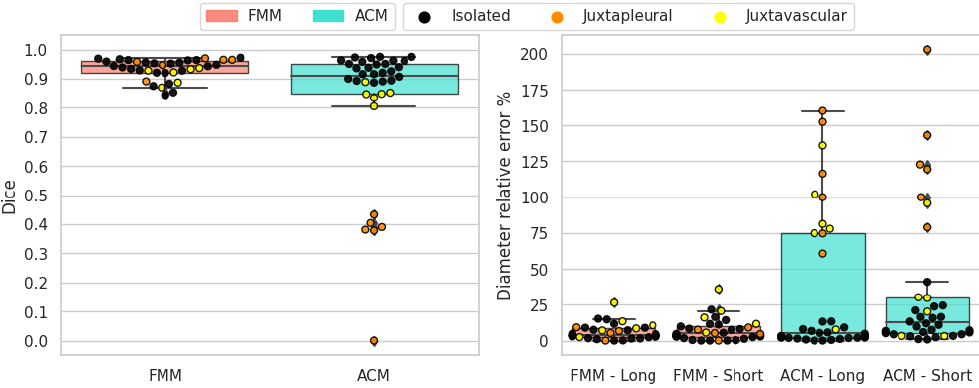
Figure 13. Solid-round nodules’ objective evaluation results as boxplots, overlayed with the values of individual cases divided into